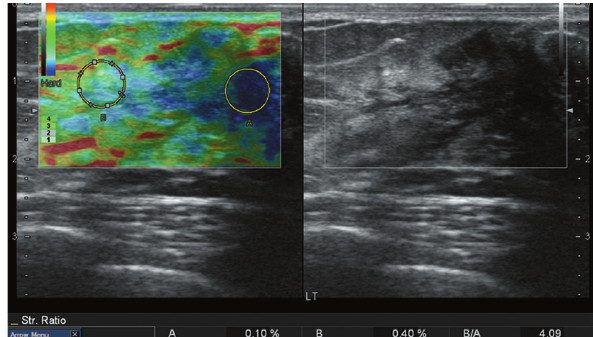
Figure 3: Ultrasound elastographic imaging showed very low strain value in the tumor and the surrounding area, scored as ES 5 based on the 5-point scoring system.